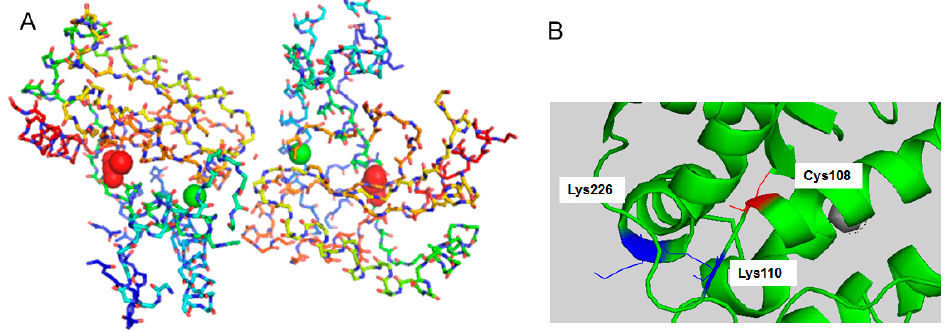
Figure 9. ( A ) VuFeSOD dimer crystal structure: 3D model for the monomer of the eukaryotic FeSOD from cowpea nodule cytosol, based on X-ray crystallography of FeSOD crystals. Iron atom presented as green circles and cysteine in red. The distance between the two Fe atoms is 18.01 Å and between the Fe atom and Cys from the same monomer 12.93 Å. ( B ) In red are the cysteine molecule (Cys108) of one monomer, and in blue are the two lysines that are near the Cys108: Lys110 and Lys226.